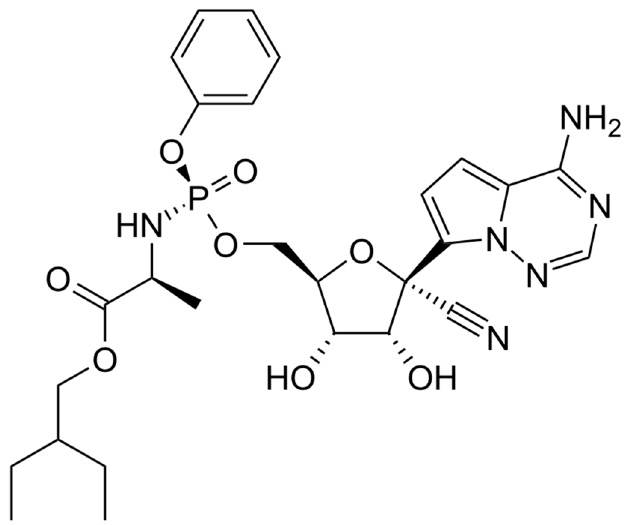
Figure 1. Remdesivir structure. Table 1. Recommended dosage of remdesivir in neonates and